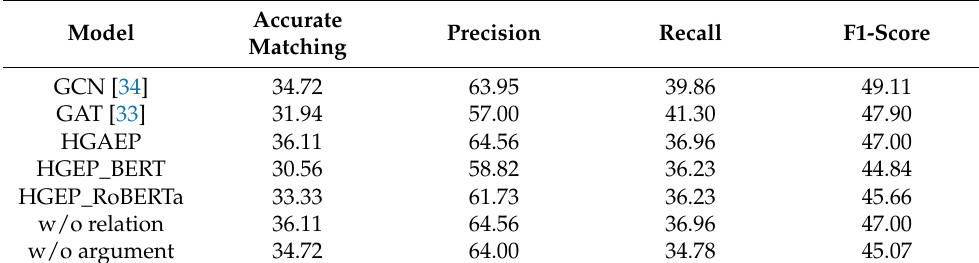
Table 3. Benchmarks and ablation experiments.